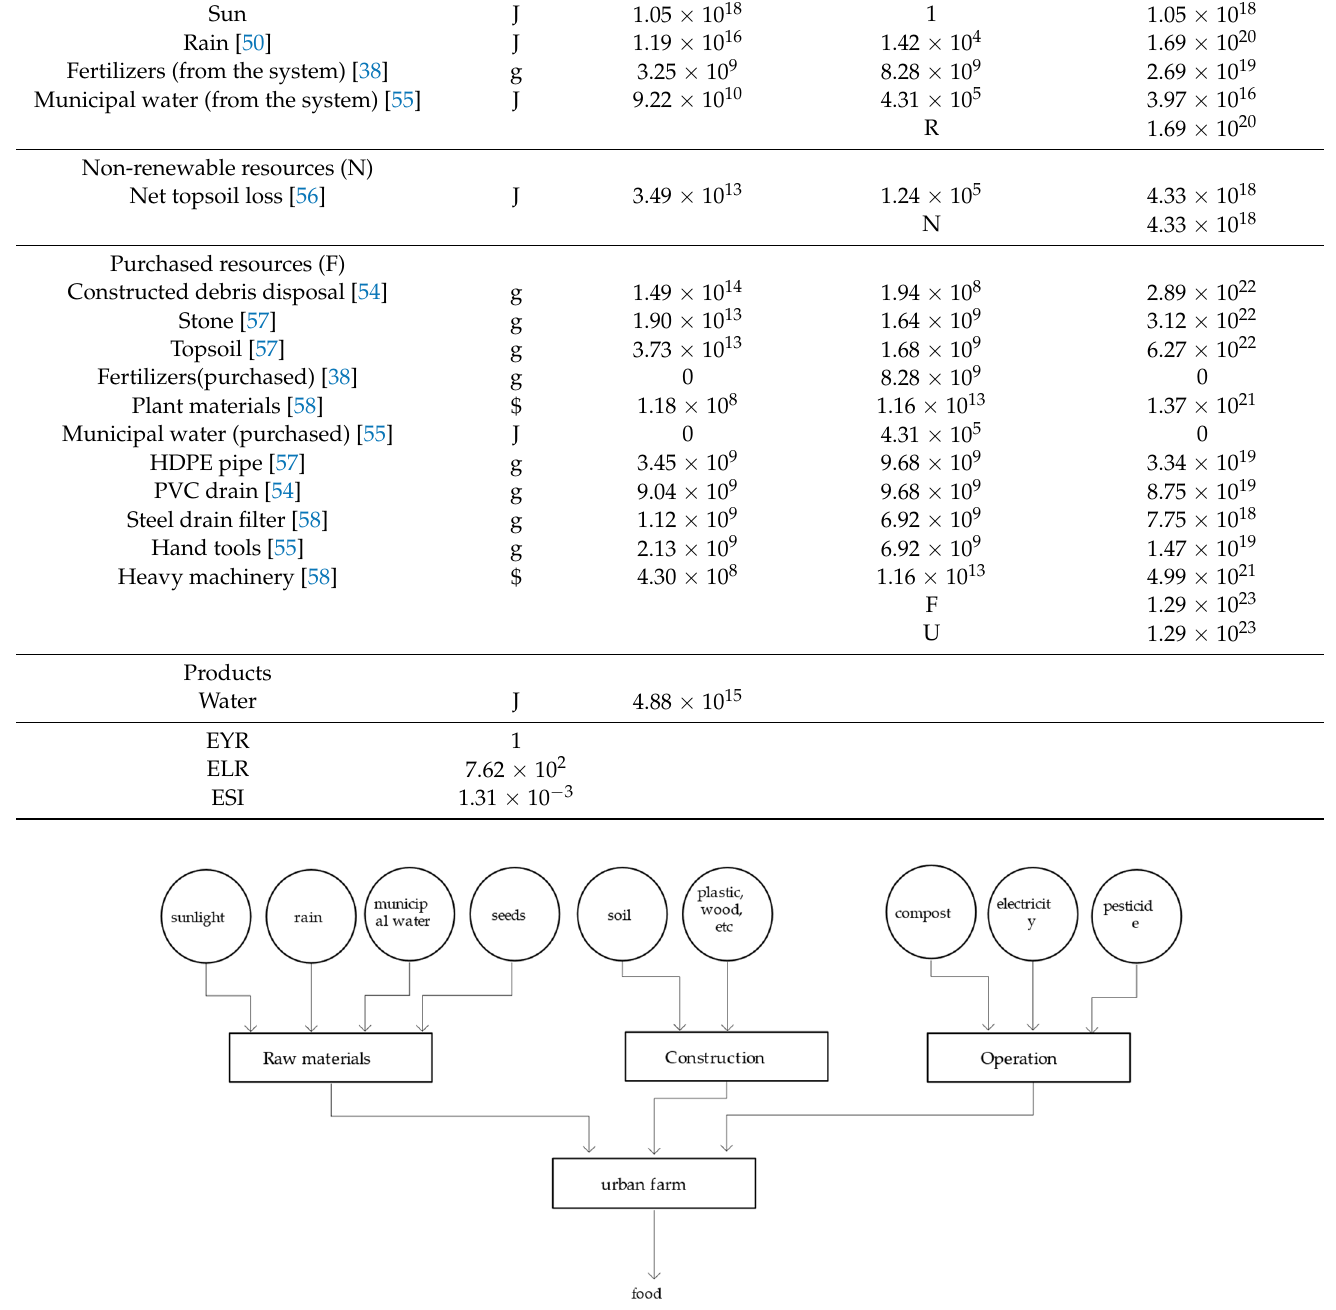
Figure 7. System diagram of the urban farm system.